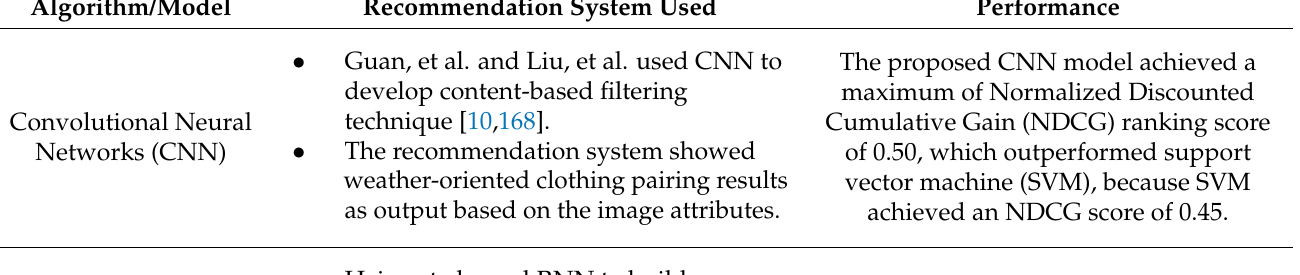
Table 3. Popular algorithmic models used in fashion recommendation systems.